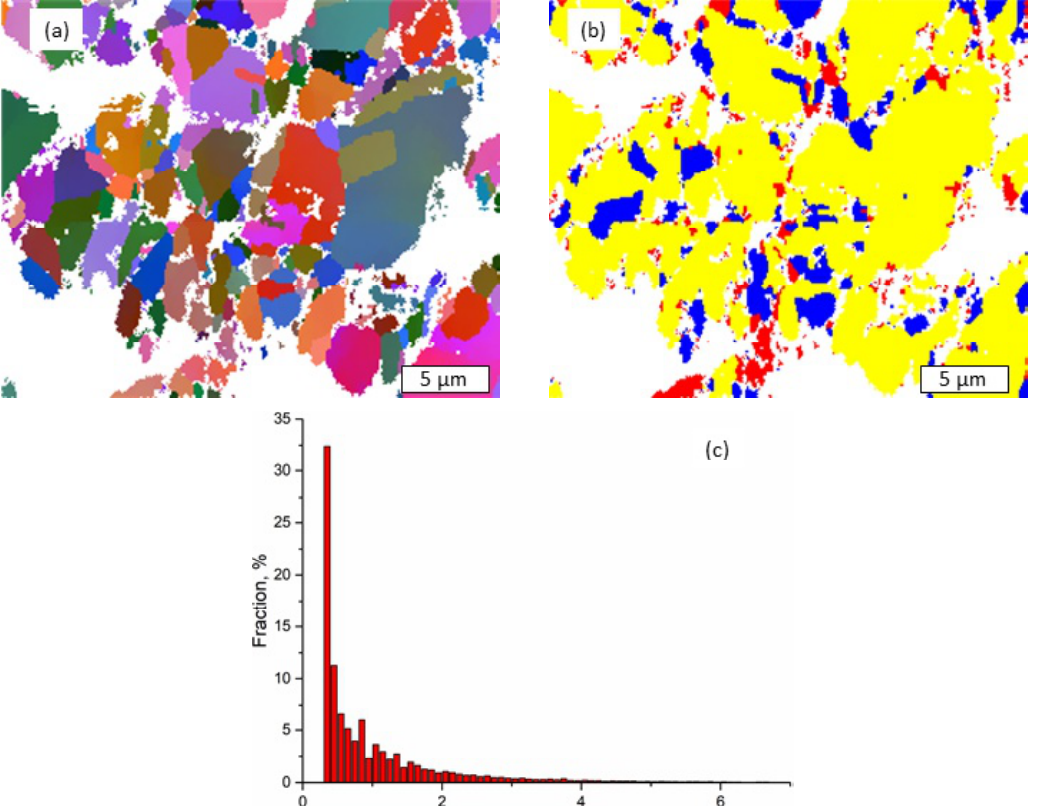
Fig. 4. (a) EBSD map of Specimen 1 (b) IPF map obtained from EBSD data (c) grain size distribution in the